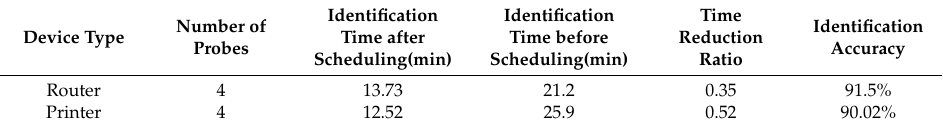
Table 5. Other types of IoT devices identification by our